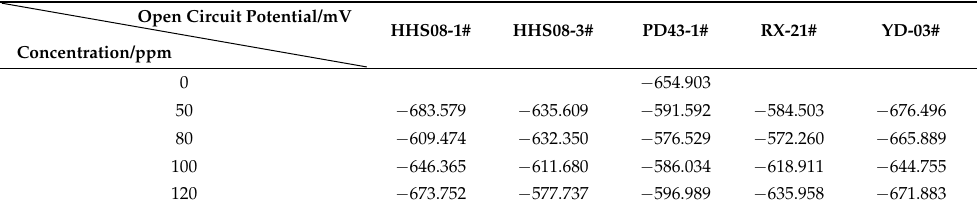
Table 4. Open circuit potential test results of corrosion